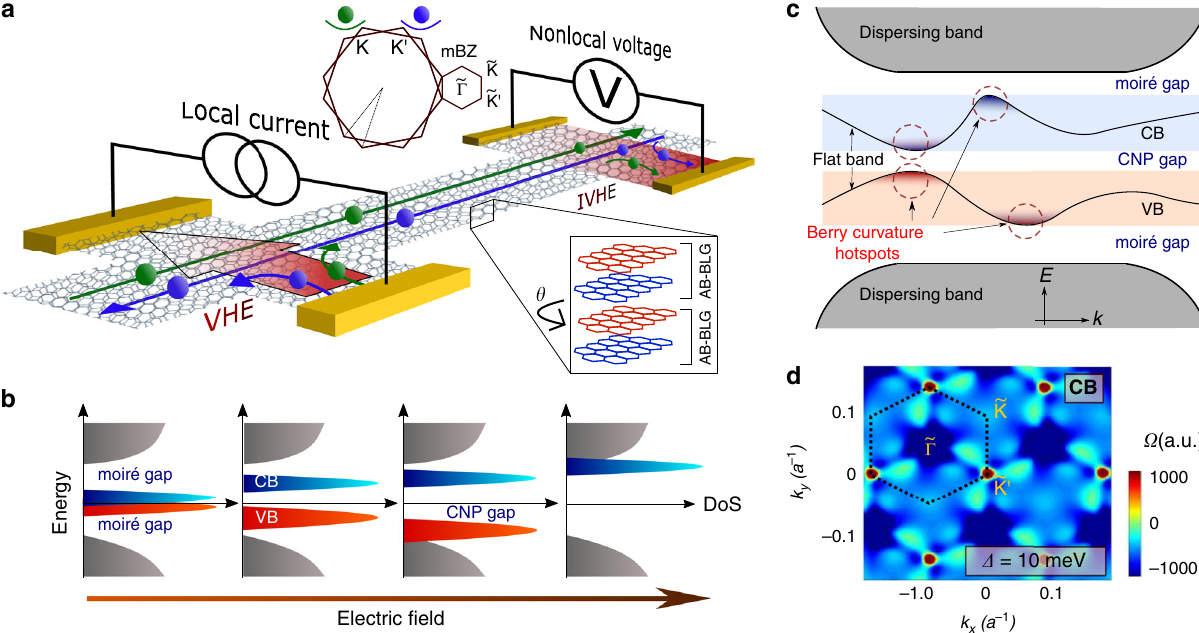
Fig. 1 Nonlocal measurement scheme and electric fi eld tunability in TDBG. a Nonlocal measurement scheme of bulk valley current. A net valley current is generated by the charge current through the local probes in its transverse direction due to nonzero Berry curvature via valley Hall effect (VHE). In the nonlocal probes, the valley current generates a voltage drop by inverse VHE. b A schematic depicting the electric fi eld tunable moiré bands in twisted double bilayer graphene (TDBG). Two low-energy fl at bands — the conduction band (CB in blue) and the valence band (VB in red) are separated from high energy dispersing bands (gray) by two electric fi eld tunable moiré gaps. CNP gap opens up between two fl at bands as electric fi eld is increased. c Schematic of a band structure of TDBG at a fi nite electric fi eld with locations of the Berry curvature hotspots encircled. d A map of calculated Berry curvature Ω in k -space for K valley of the conduction fl at band at a fi nite electric fi eld corresponding to interlayer potential difference Δ = 10 meV. Here a is 0 the lattice constant of graphene. This map shows the hotspots located at the symmetry points ~ Γ , ~ K, and ~ K in the moiré Brillouin zone. The Berry curvature for K 0 valley has same magnitude but opposite